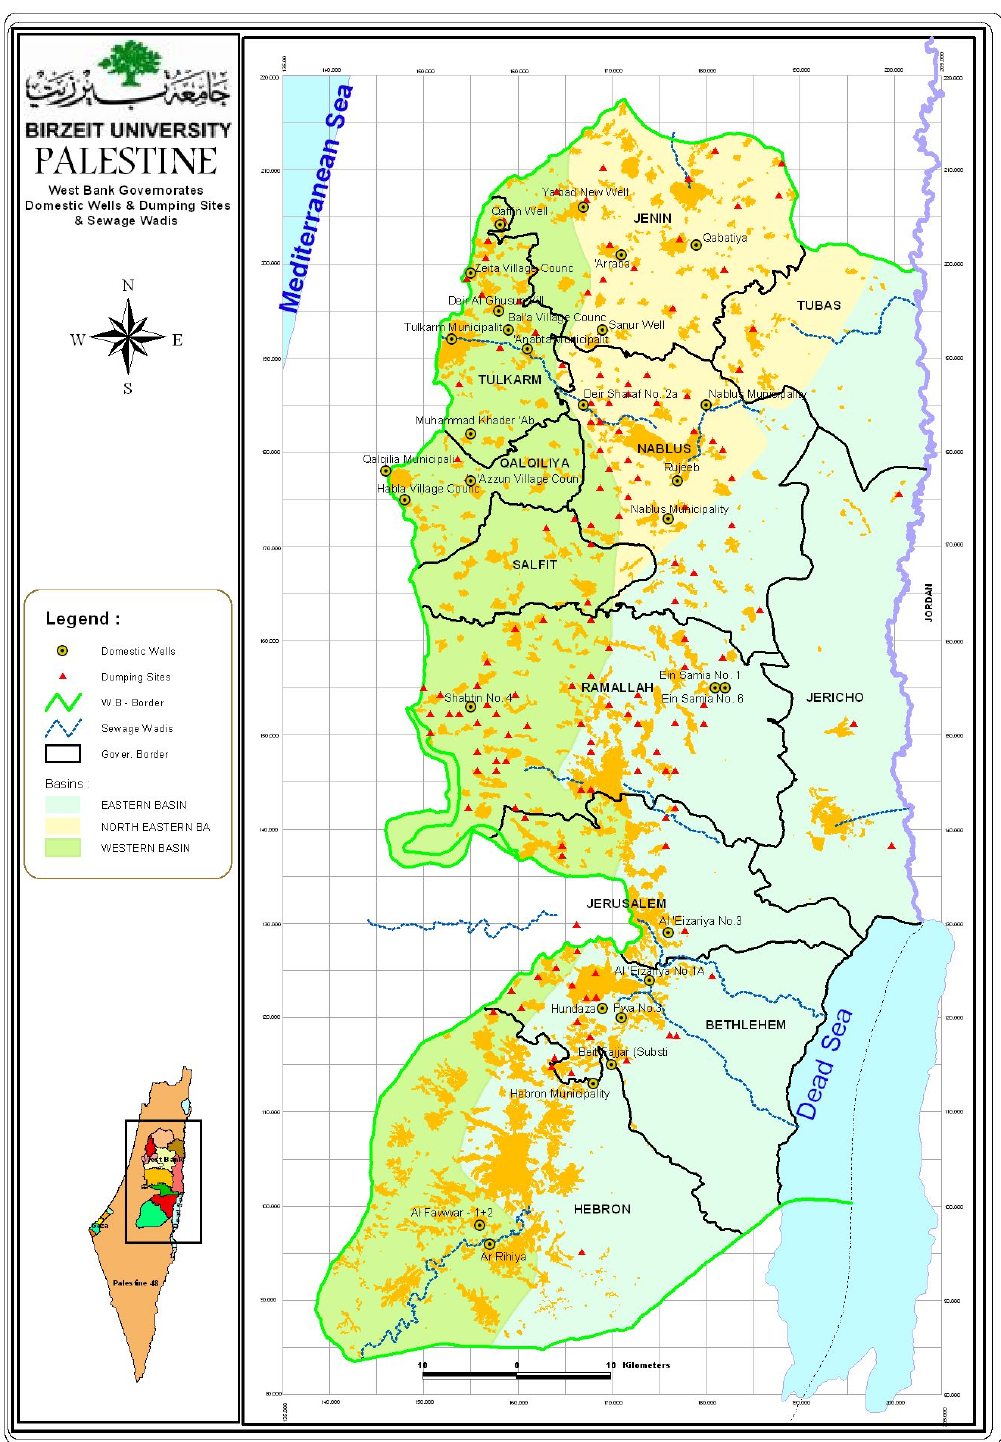
Figure 3. The sampled groundwater wells, wadis polluted with sewage, and non-engineered solid waste dumping sites in the West